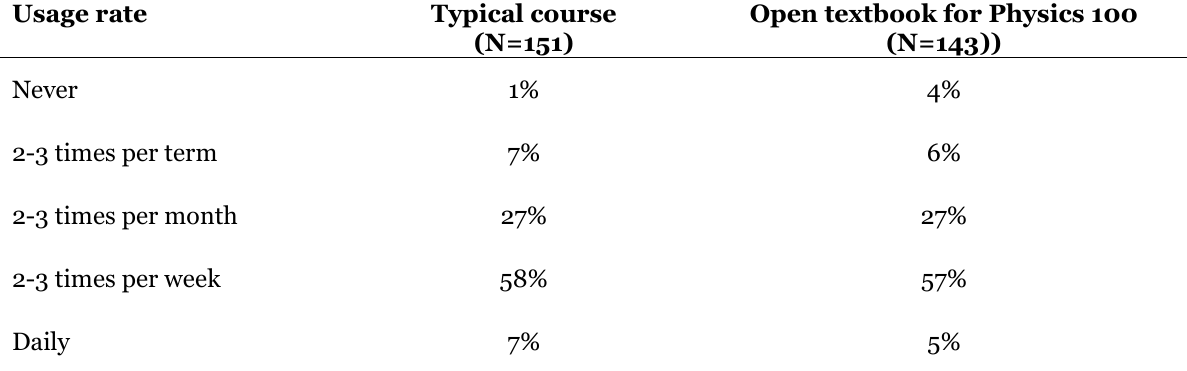
Reported Usage Rates of Textbooks Usage